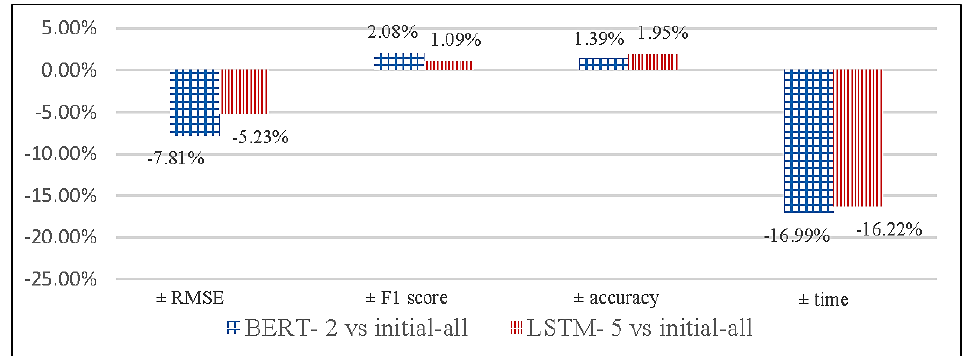
Table 9. Results achieved per each model with three datasets generated from Kindle Store.